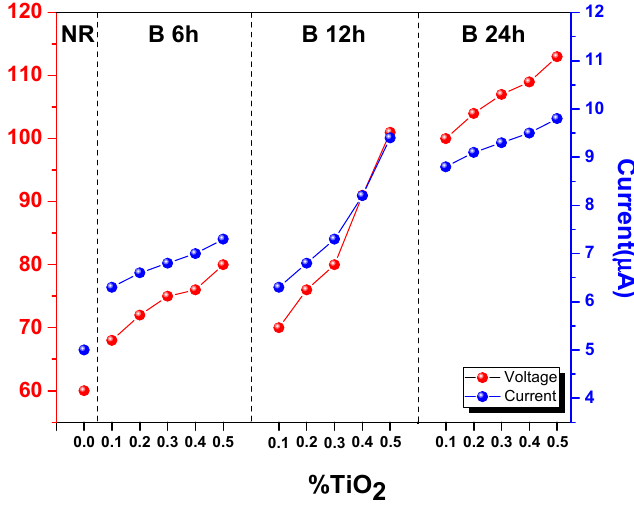
Figure 4. Electrical voltage and current of NR TENG and the NR-TiO 2 - composite TENGs fabricated from ball-milled TiO 2 at 6, 12, and 24 h at 0.1–0.5%wt concentration.